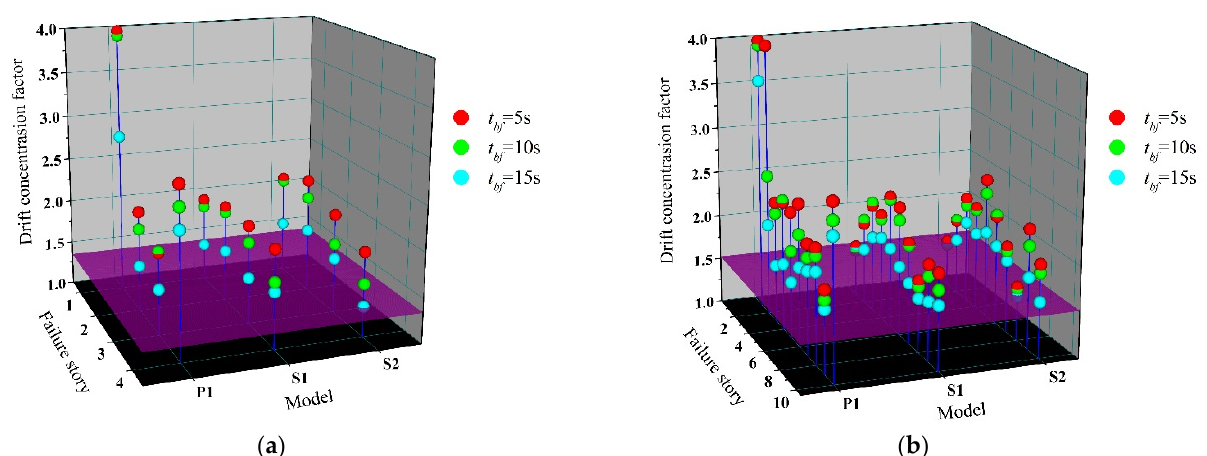
Figure 18. Drift concentration factor of residual structure. ( a ) 4-story; ( b ) 10-story.